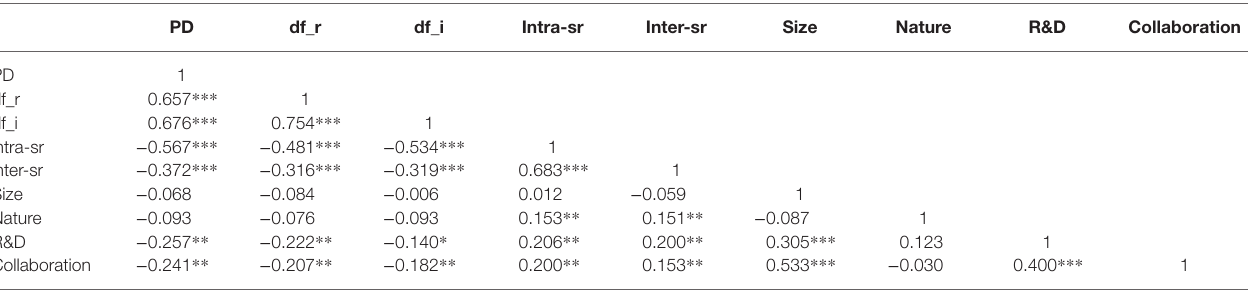
TABLE 3 | Correlation analysis of the